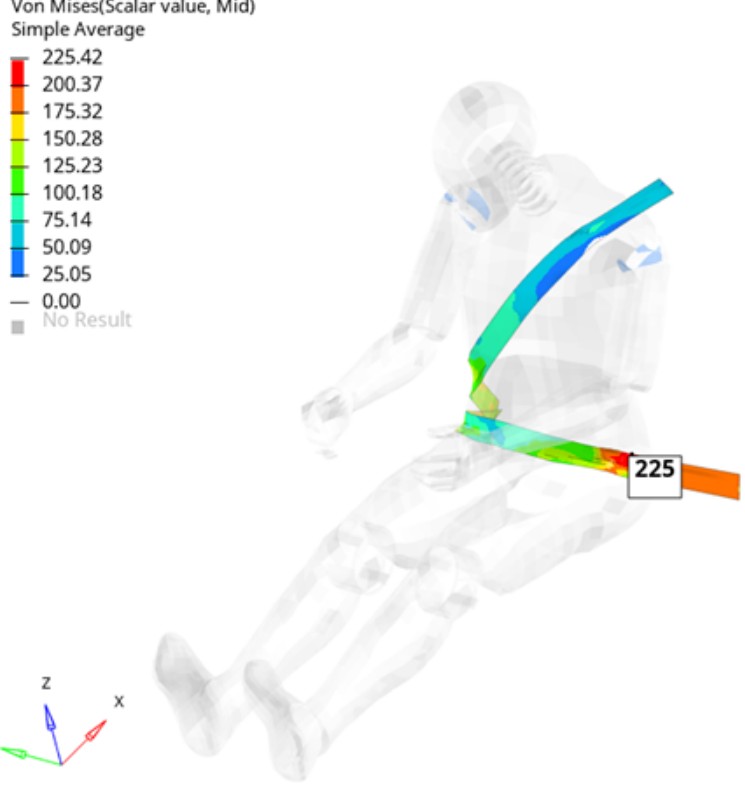
Figure 16. Stress in the belt when T = 0.055 s (in MPa).